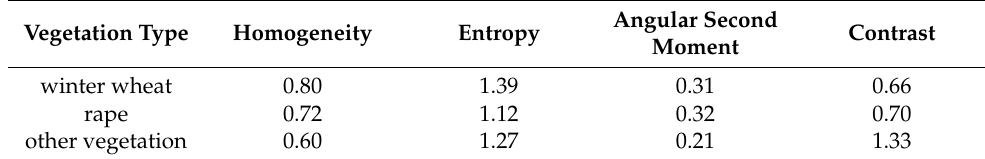
Table 4. Statistics of texture characteristics of three vegetation types in FI 16m